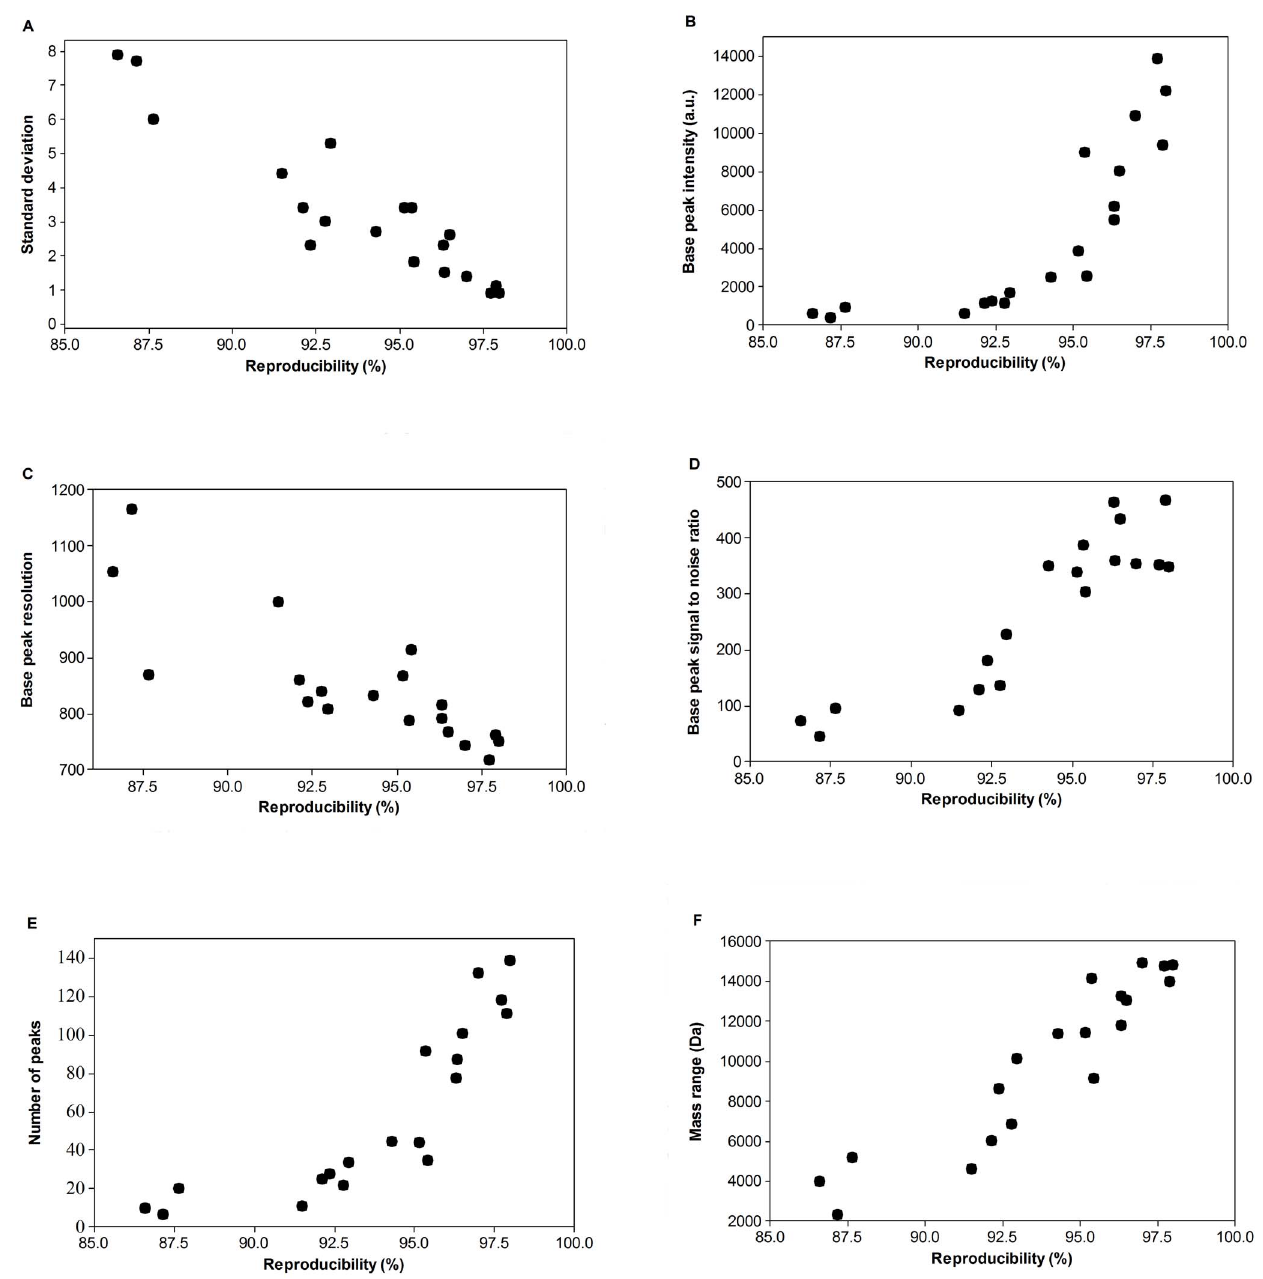
Figure 1. Characterization of spectra exhibiting varying levels reproducibility. Metrics of quality include standard deviation (A), base peak intensity (B), base peak resolution (C), base peak S:N (D), number of peaks (E), and mass range